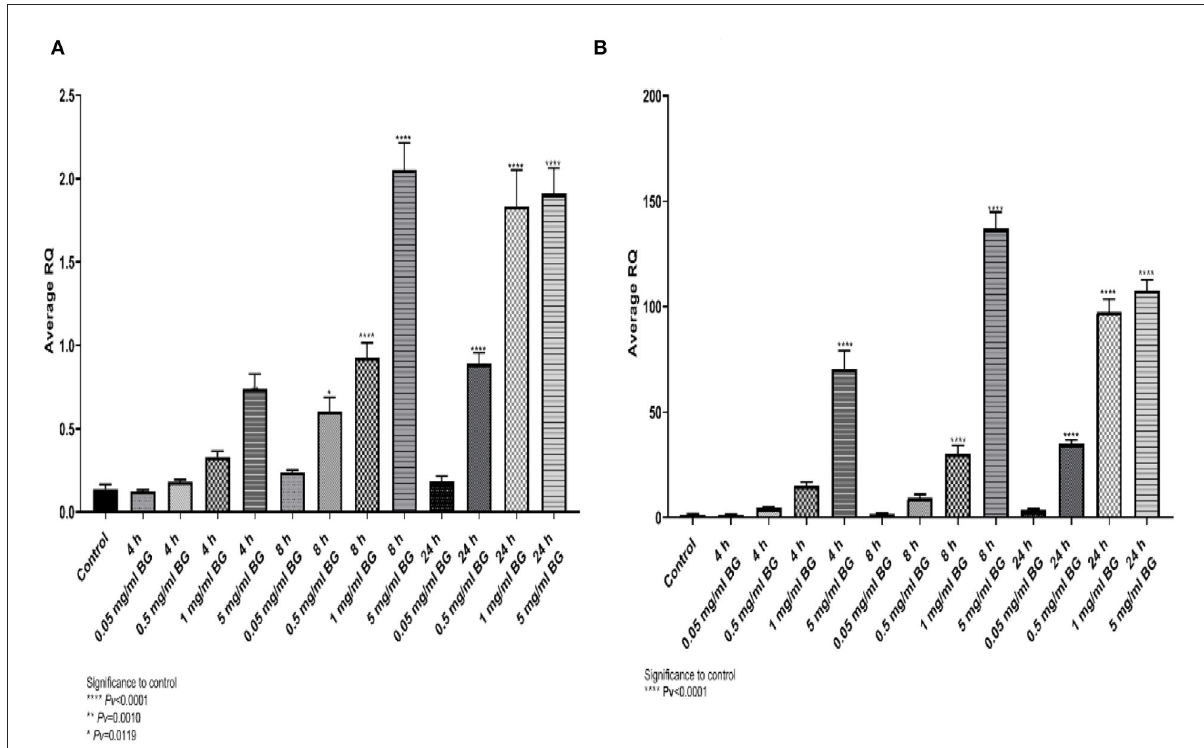
FIGURE1 (A) Average relative expression for the gene TNF α , (B) the relative fold gene expression (DDCT) for the gene IL4, after exposure to algae beta-glucans at 3-time points and 4 concentrations (n = 6). ****Pv < 0.000.1, **Pv = 0.0010, *Pv = 0.0119—compared to control.